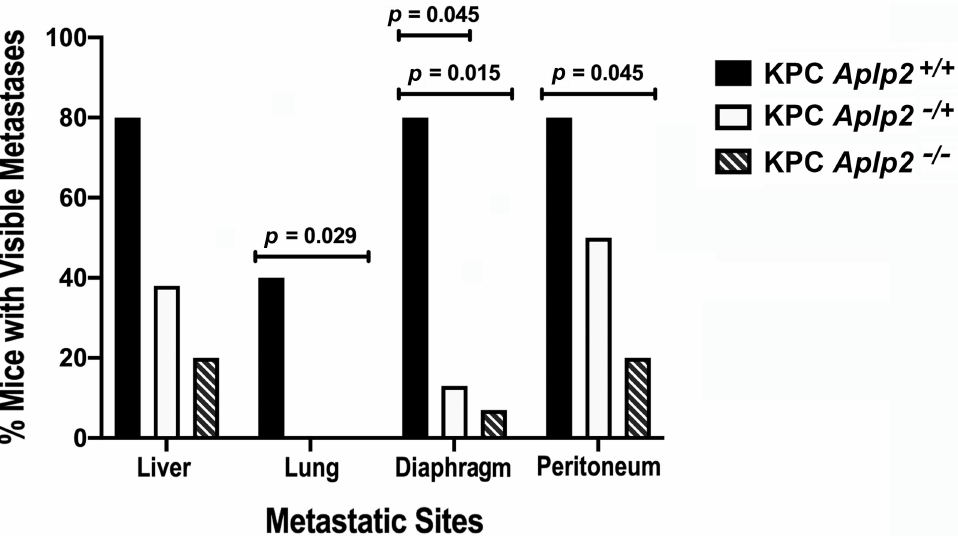
Figure 4. Metastatic pancreatic tumor spread was decreased upon homozygous and (to a lesser extent) heterozygous loss of APLP2 in the background of KPC. At necropsy, the liver, lung, diaphragm, and peritoneum were assessed. Mice with homozygous loss of APLP2 in the pancreas had significantly fewer metastases to the lung ( p = 0.029), diaphragm ( p = 0.015), and peritoneum ( p = 0.045) than wild-type mice. Two-way ANOVA and Tukey’s multiple comparisons test were used to compare the overall metastatic spread between groups. Fisher’s Exact Test with Bonferroni Method Adjustment was used to compare specific metastatic sites between